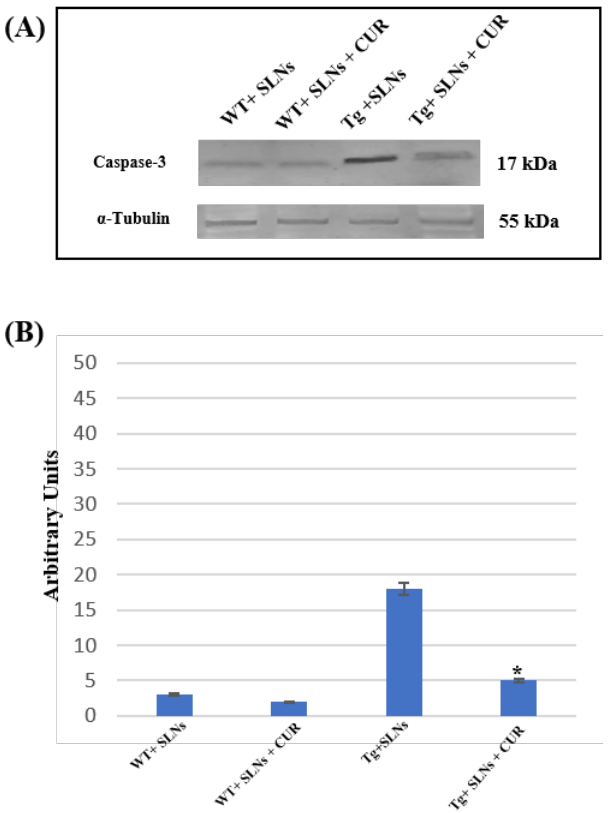
Figure 5. ( A ) Caspase-3 cleavage in total cellular lysate from WT-SLNs, WT-SLNs-CUR, Tg-SLNs, and Tg-SLNs-CUR mice systemically administrated for 3 weeks relieved by Western blot. ( B ) Den- sitometric analysis of caspase-3 cleavage expression performed after α -tubulin normalization. The results are expressed as the mean ± S.D. of the values of five separate experiments performed in triplicate. * p < 0.05 Tg-SLNs-CUR vs. Tg-SLNs.